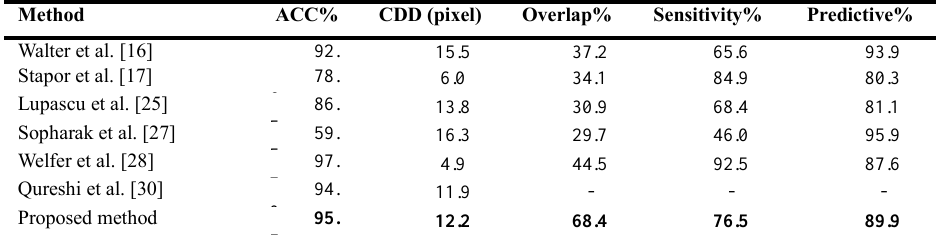
Table 3. Obtained performance of all methods on DIARETDB1 database. Best values are bold.